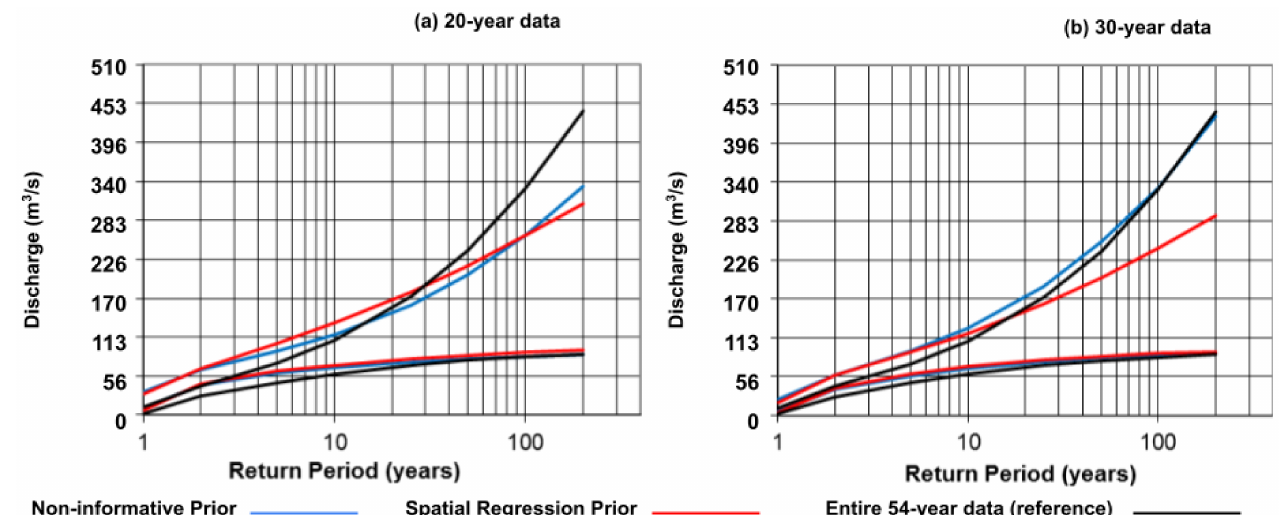
Figure 6. Applying spatial regression prior to ( a ) 20-year and ( b ) 30-year data series. In Figure 6, both the 20-year model and the 30-year model have similar upper